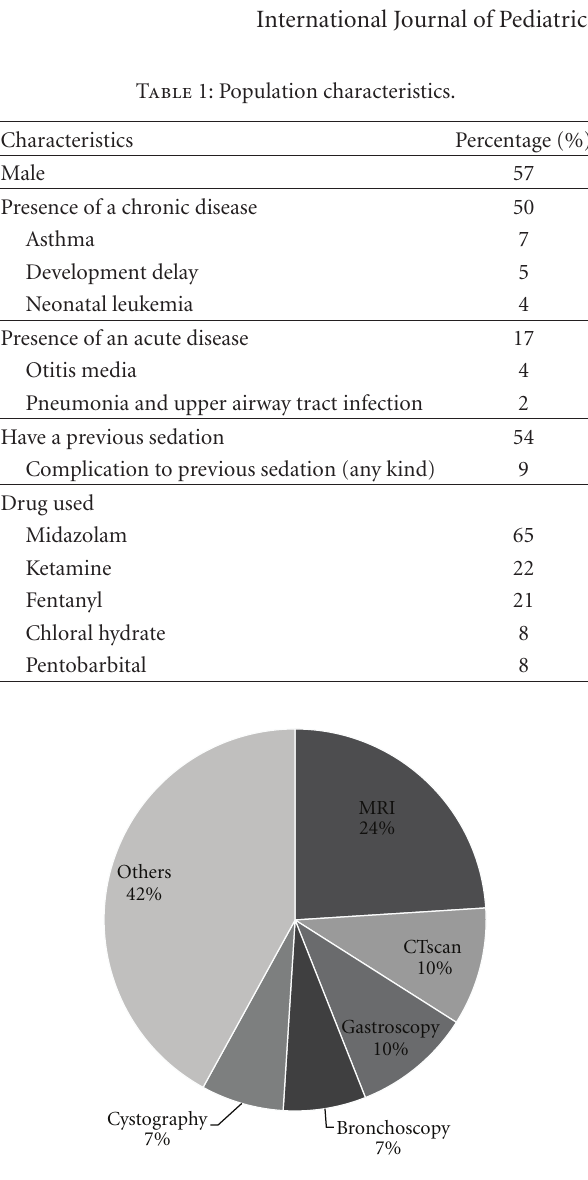
Figure 1: Most frequent